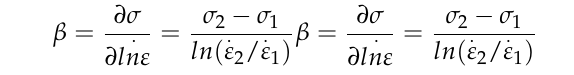
Figure 9. Stress–strain curves for different specimens at the same strain rate under dynamic loading conditions. ( a ) Strain rate of 700 s − 1 . ( b ) Strain rate of 1500 s − 1 . ( c ) Strain rate of 2000 s − 1 . ( d ) Strain rate